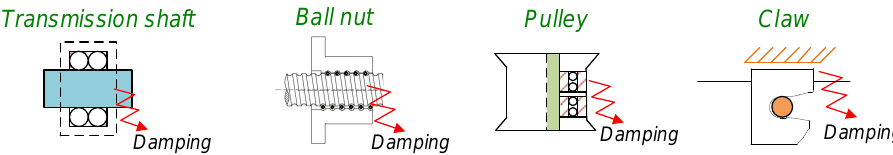
Figure 10. Motion damping schematic diagram of the ETD.